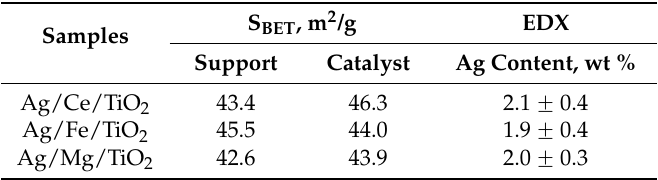
Table 1. Textural properties of supports and catalysts and analytical silver content of the catalysts treated in H 2 at 300 °C for 1 h.